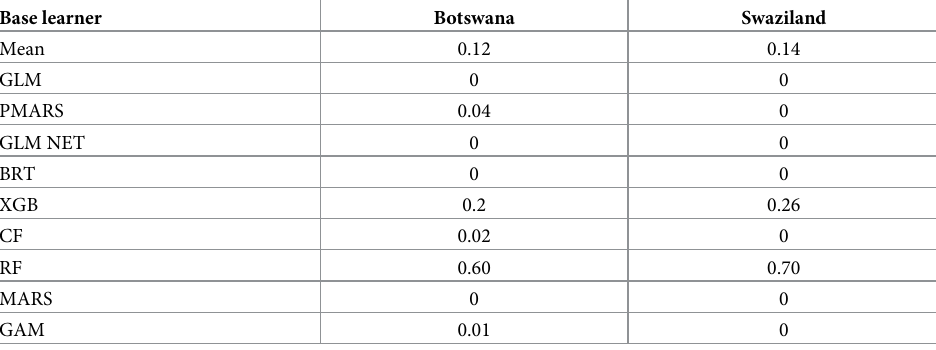
Table 3. Coefficients estimated for each base learner by the super leaner